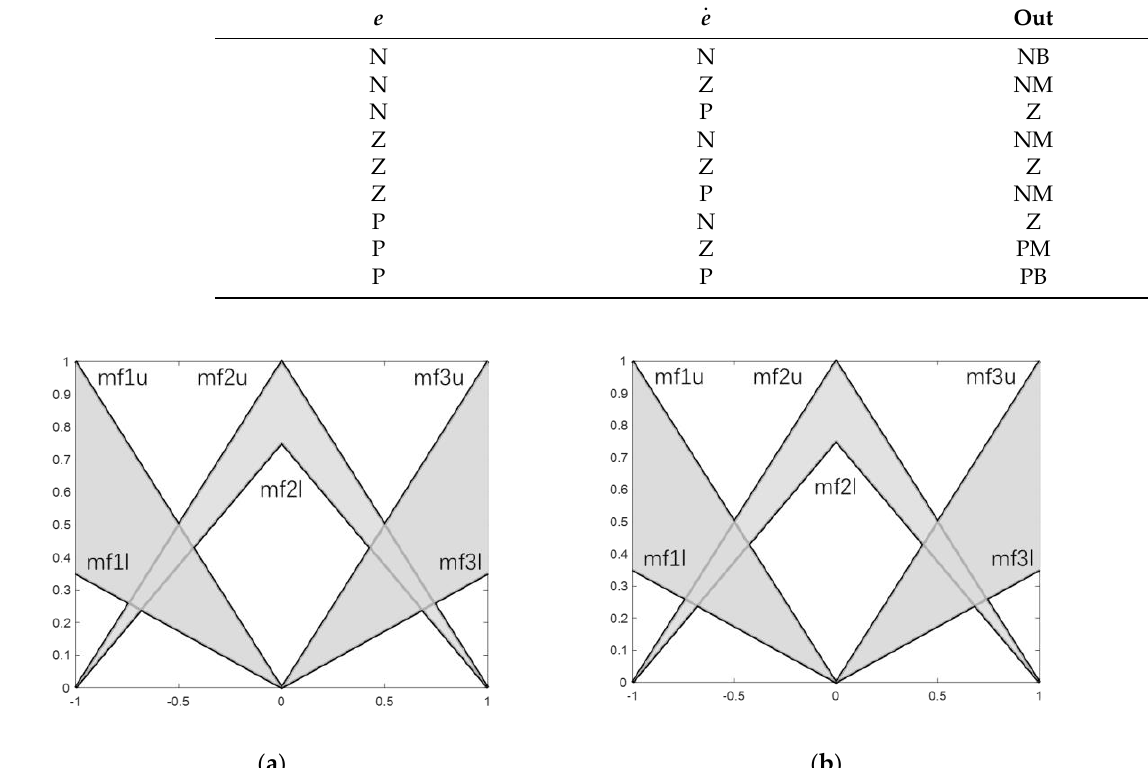
Figure 5. Membership function distribution for ( a ) 𝑒 and ( b ) 𝑒̇ input with IT2FS. Table 3. Fuzzy rules used by the FC.